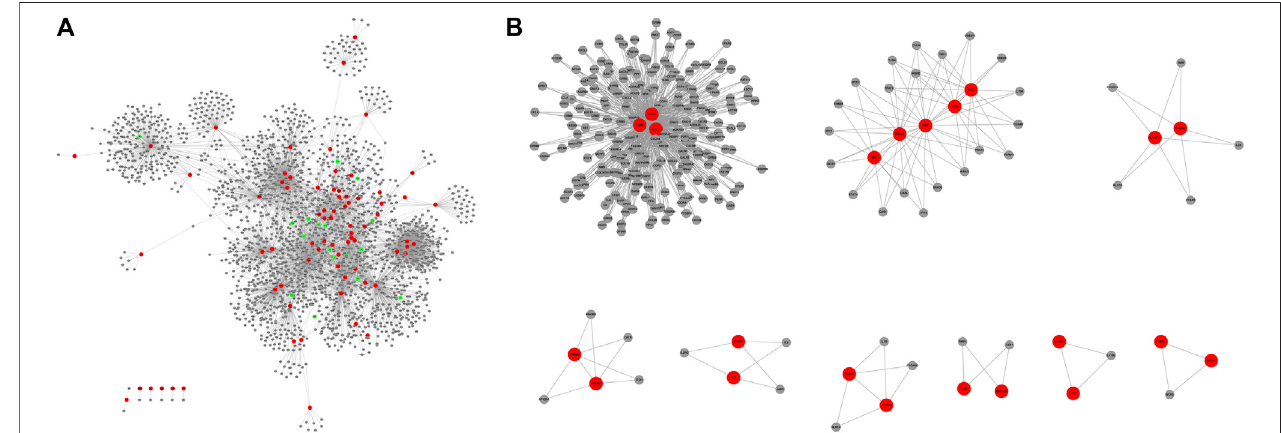
FIGURE1| Inthe fi gure,therednoderepresentsthein fl uenzavirus-relatedmolecule,thegraynoderepresentsthe fi rst-orderneighborofthein fl uenzavirus-related molecule, and the green represents the geniposide-related molecule.